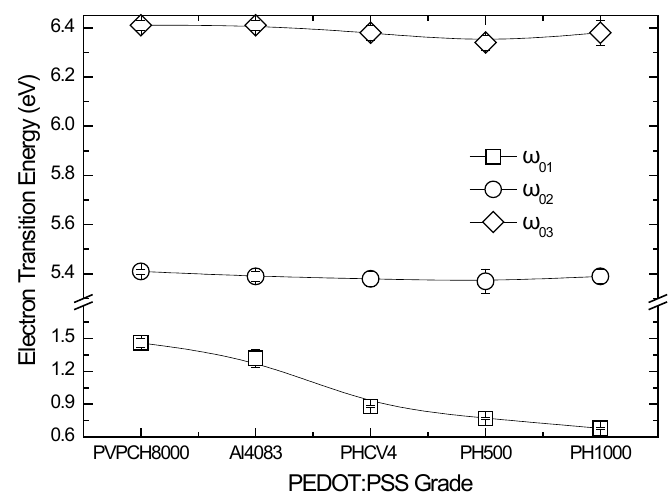
Figure 4. Calculated electronic transition energies of the different PEDOT:PSS formulations.